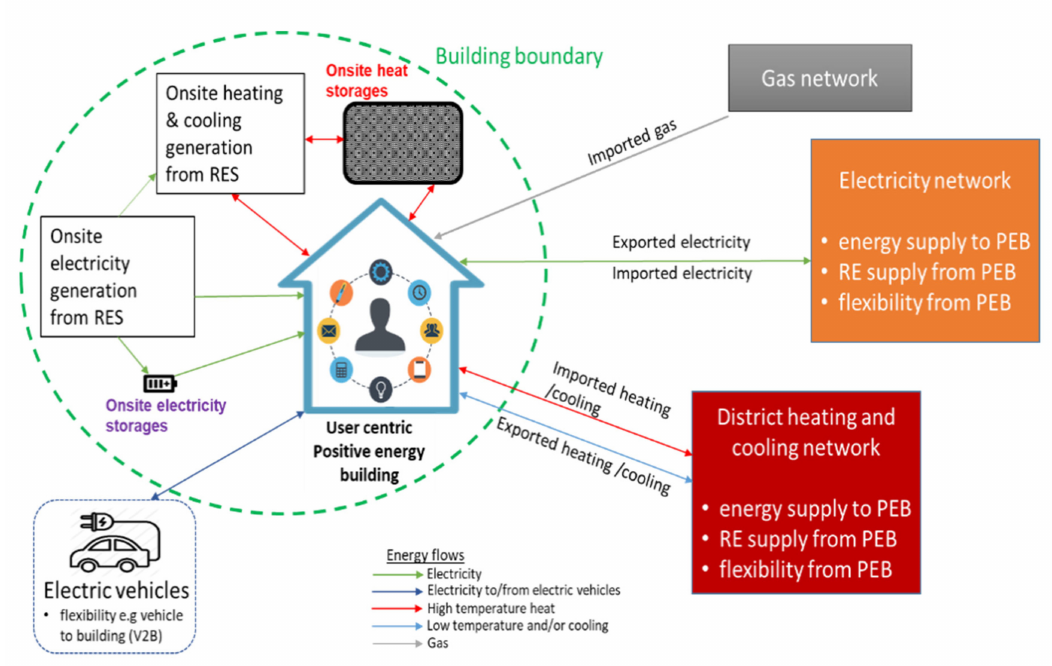
Figure 1. The positive energy building concept, in terms of technical- and social-centric